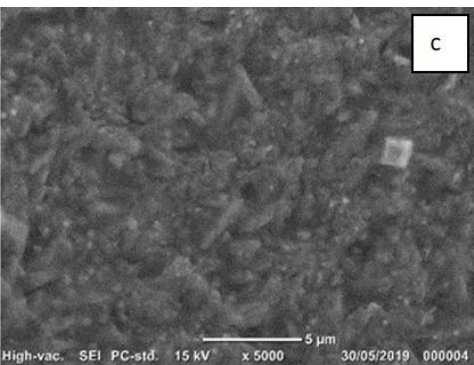
Figure 3. ( a – c )—Scanning electron images of the mixed mode failure in a representative sample of Group 2 (5% HF for 90 s). ( a , b ) The lithium disilicate surface (black area) is covered partly with cement (white area) (×440). ( c ) Lithium disilicate crystals are visible following the removal of the glassy phase (×5000).